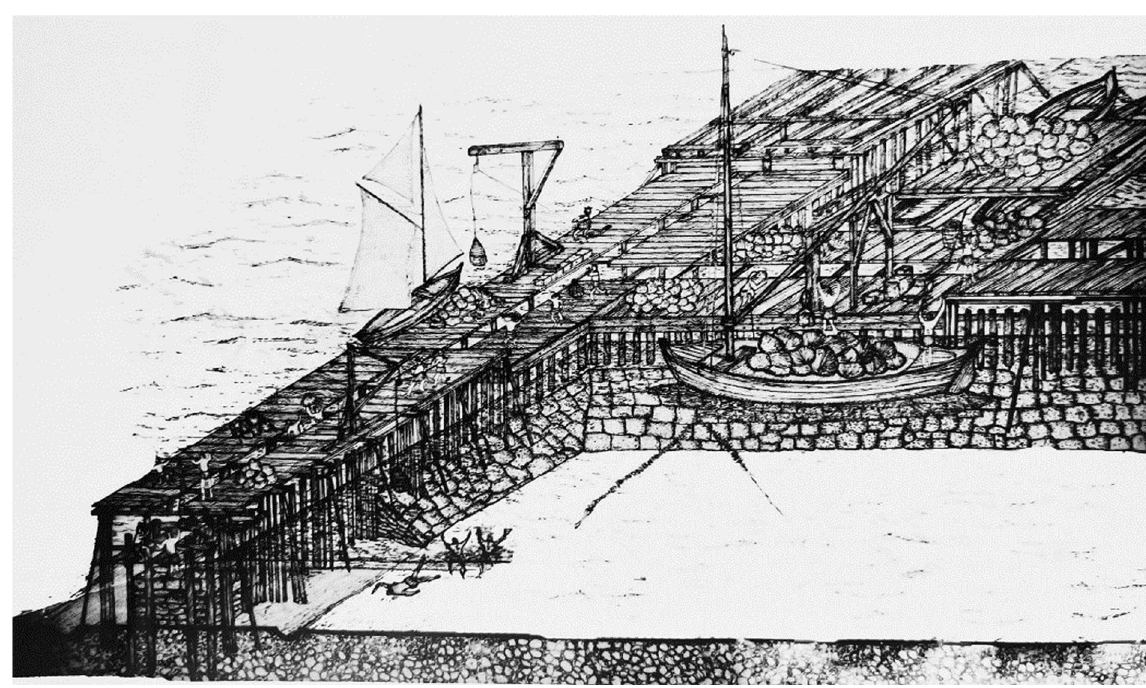
Fig. 3 Isometric view of the construction of the Bocagrande breakwater, hypothetical drawing. Draft taken and adapted from (Cabrera Cruz et al. 2019)